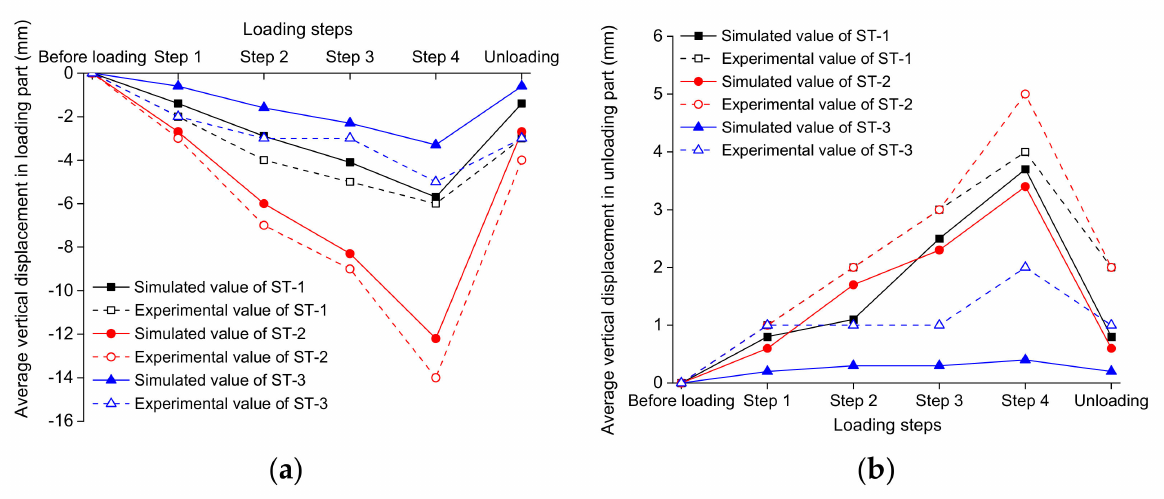
Figure 26. Vertical displacement of the upper nodes on the struts for the half-span static loading test. ( a ) Loading part; ( b ) Unloading